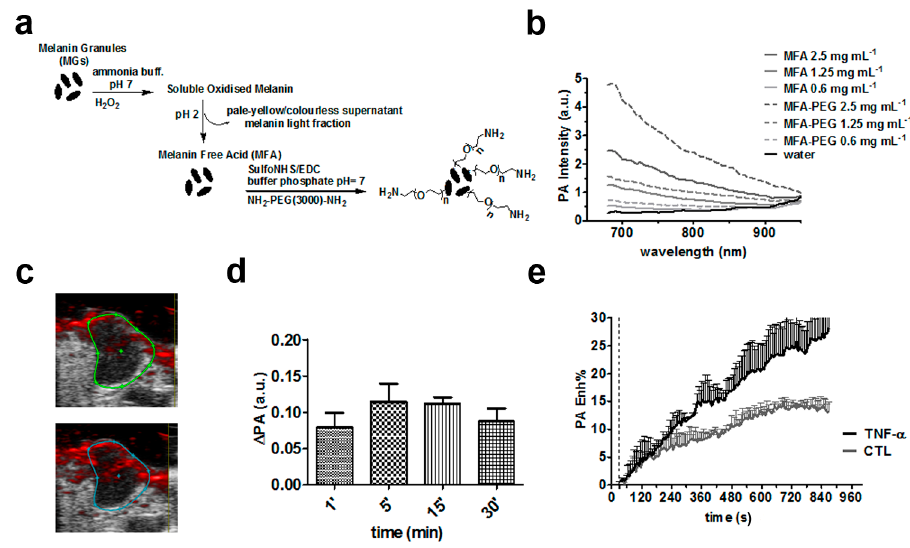
Figure 1. ( a ) Schematic illustration of the preparation of melanin-free acid derivatives (MFA) and their PEGylated form (MFA-PEG); ( b ) optoacoustic (OA) emission spectra of MFA and MFA-PEG at several concentrations in 1 × PBS and pH = 7.4; ( c ) representative optoacoustic images in transverse section of tumor before (top) and 5 min after (bottom) intravenous injection of MFA-PEG (concentration: 2.5 mg/mL, volume: 0.1 mL) at 700 nm; ( d ) average OA signal changes in breast tumor-bearing mice ( n = 4); and ( e ) averaged dynamic contrast-enhanced OA curves (OA Enh %) upon MFA-PEG tail vein injection for the control ( n = 3) and TNF- α treated ( n = 4) group, showing increased OA enhancement following antiangiogenic treatment. Reprinted with permission from reference [31], Copyright 2016, John Wiley and Sons.